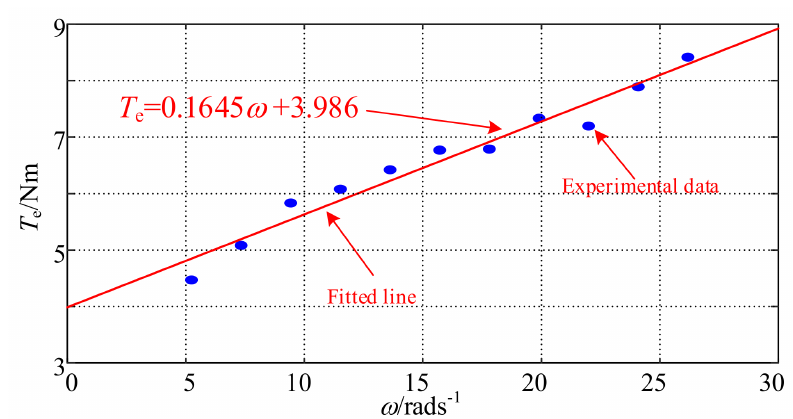
Figure 9. Fitting curve of viscous friction coefficient and Coulomb friction